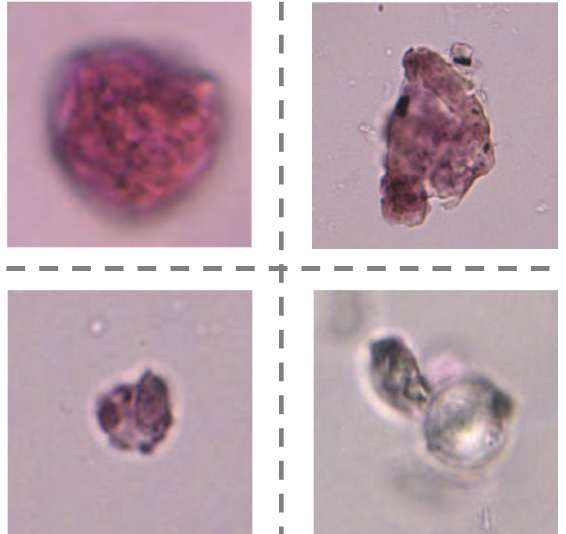
Figure 11. Some examples of misclassification from “Data preprocessing+ Fined-grained classifica- tion”